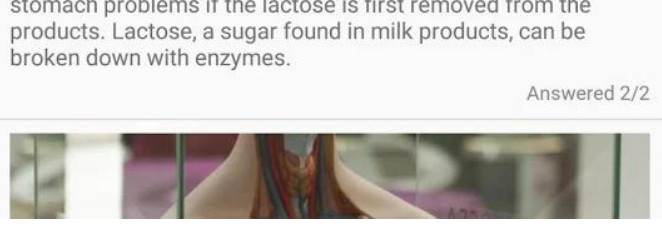
Figure A2. A Screenshot of the Non-AR App Game Figure B1. A Screenshot of the Non-AR App Game Mode.